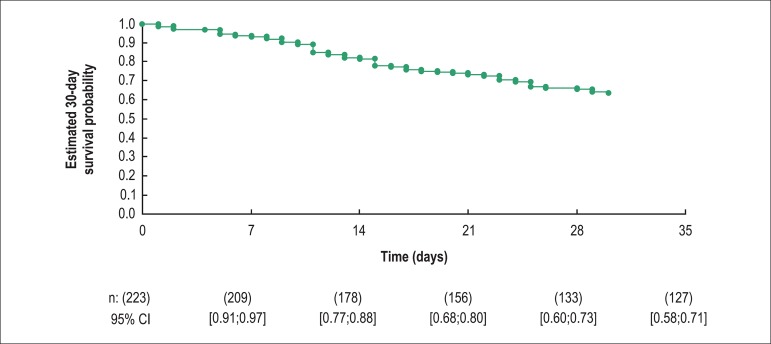
Thirty-day survival curve.